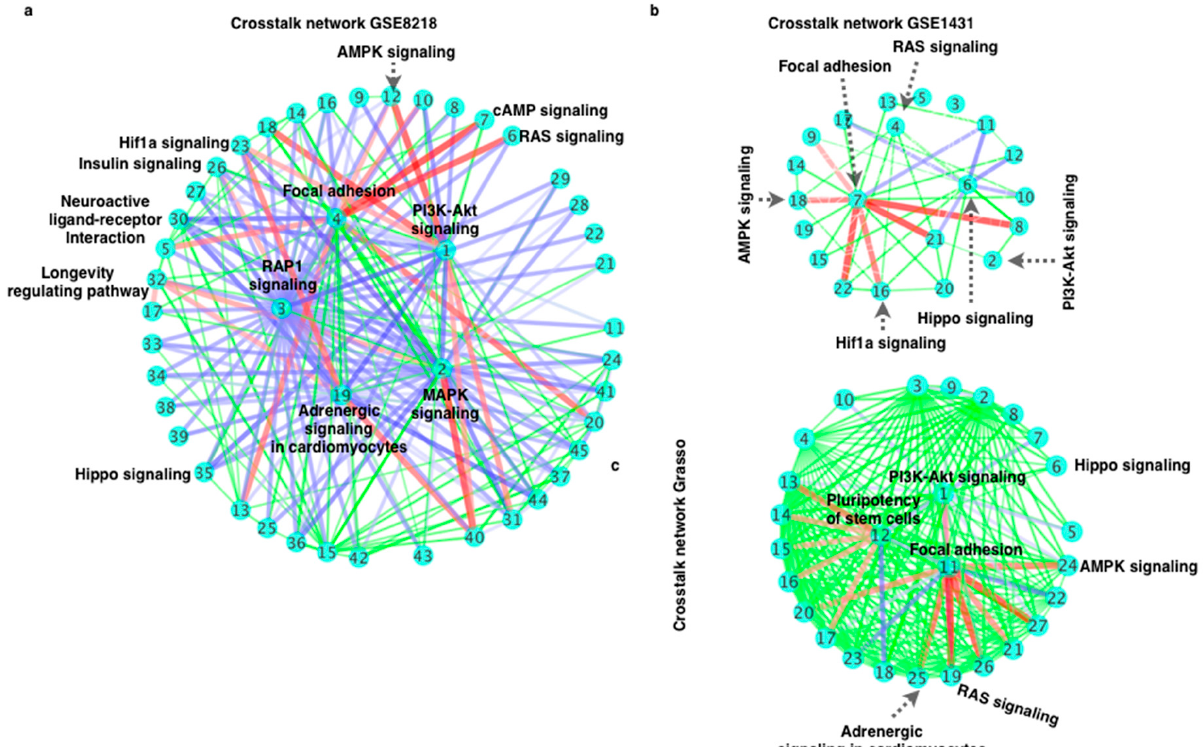
Figure 4. CT degree analysis for the enriched pathways: Degree of crosstalk between the pathways for ( a ) GSE8218, ( b ) GSE1431, and ( c ) Grasso dataset. Different thickness of the edges represents the degree of crosstalk between the pathways (higher the higher the CT degree , and lower thickness means lower CT degree ). Different edges colors are for clarity